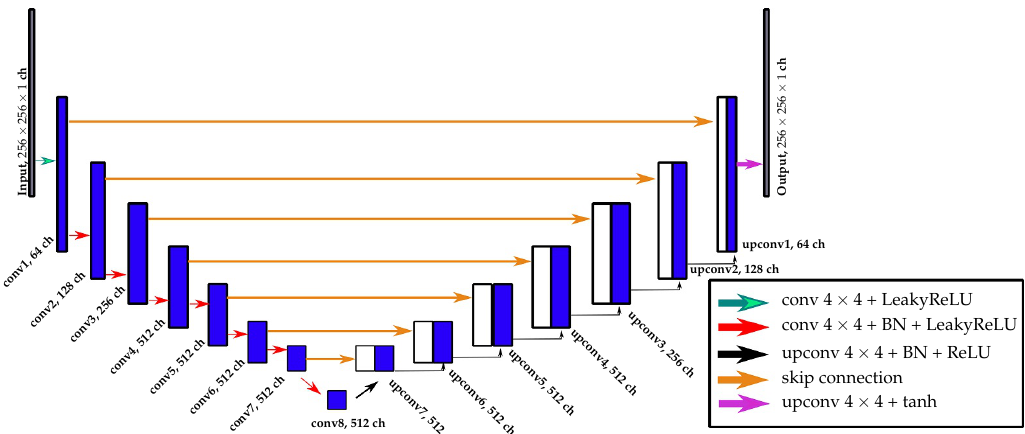
Figure 1. Schematic overview of the proposed U-Net architecture. Each convolution operation has a kernel of size 4 × 4 with stride 2. For up-sampling, the transposed convolution operations with kernels of size 4 × 4 and stride 2 are used. The Leaky ReLU activation function in the encoder part of the network has a negative slope of